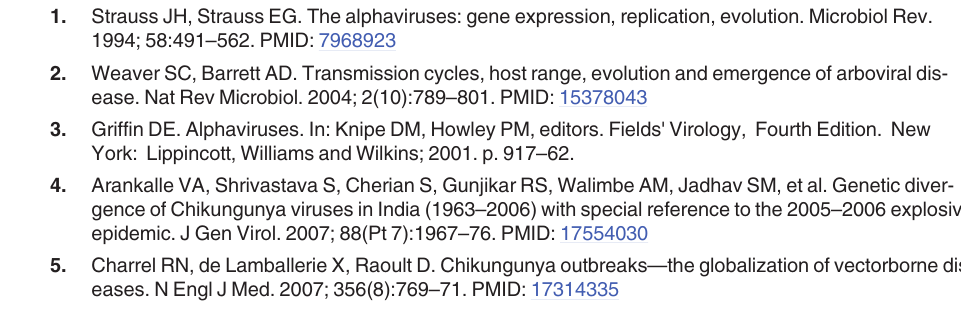
S2 Fig. IFN- β pretreatment inhibits GFP expression from subgenomic RNA, delivered by EIL/GFP/VEEV viral particles. NIH 3T3 cells were either treated with 500 IU/ml of IFN- β or mock-treated and then infected with EIL/GFP/VEEV at an MOI of 20 PFU/cell. GFP expres- sion was evaluated at 4 h post infection. (TIF) S3 Fig. Expression of nLuc increases for at least 24 h in C7/10, but not NIH 3T3, cells. NIH 3T3 and C7/10 cells were infected at the same MOI with EIL/nLuc/VEEV. Cells were harvested at the indicated time points, and nLuc activities were assessed. Data were normalized to nLuc activities measured after virus adsorption to the cells. (TIF) S4 Fig. Binding of EIL/nLuc/VEEV to NIH 3T3 cells. NIH 3T3 cells were incubated with in- dicated doses of purified EIL/nLuc/VEEV for 1 h at 4 ° C. After washing, cells were lysed and nLuc activity was assessed. (TIF) S5 Fig. Computer-predicted (m-Fold) secondary structures of the 5 ’ UTRs used in transla- tion experiments and the recombinant viruses, designed in this study. The introduced or identified mutations are indicated in red. (TIF) S6 Fig. Analysis of IFIT1 expression in selected clones of wt IFIT1 KI MEFs and IFN- β - treated MEFs by Western blot. Data were normalized to β -tubulin levels and the expression level of IFIT1 detected in mock-treated wt MEFs.